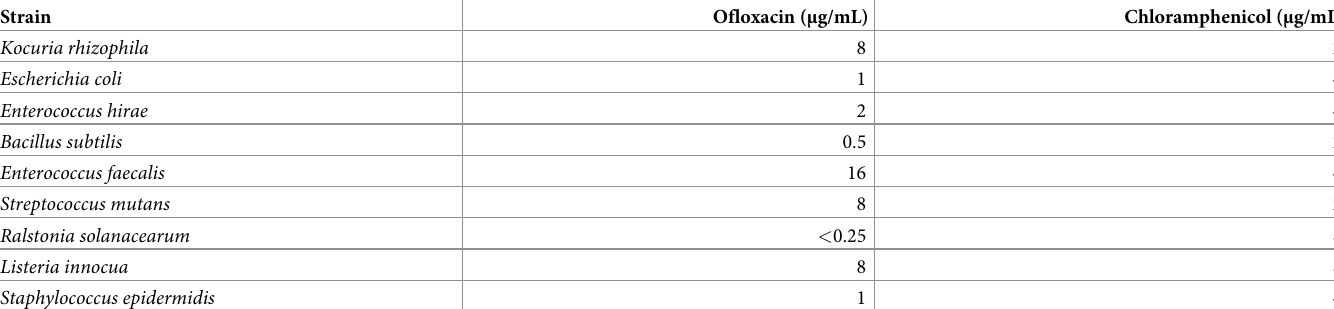
Table 4. Minimum inhibitory concentration (MIC) of ofloxacin and chloramphenicol against test strain cultured in NYB.